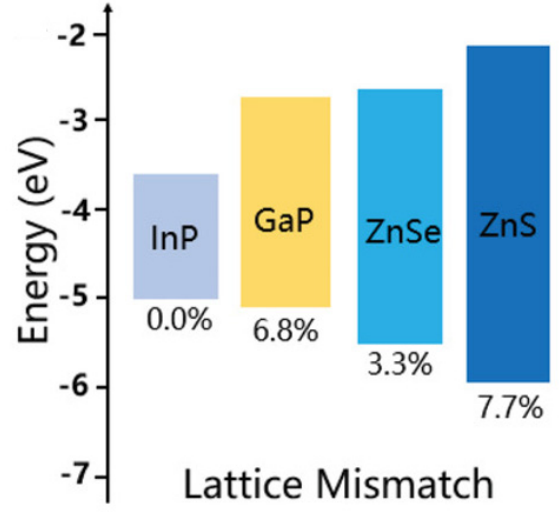
Figure 5. Lattice mismatch between core InP and shell materials of GaP, ZnSe, and ZnS. Reprinted with permission from Ref. [76]. © 2020, Wiley − VCH GmbH.